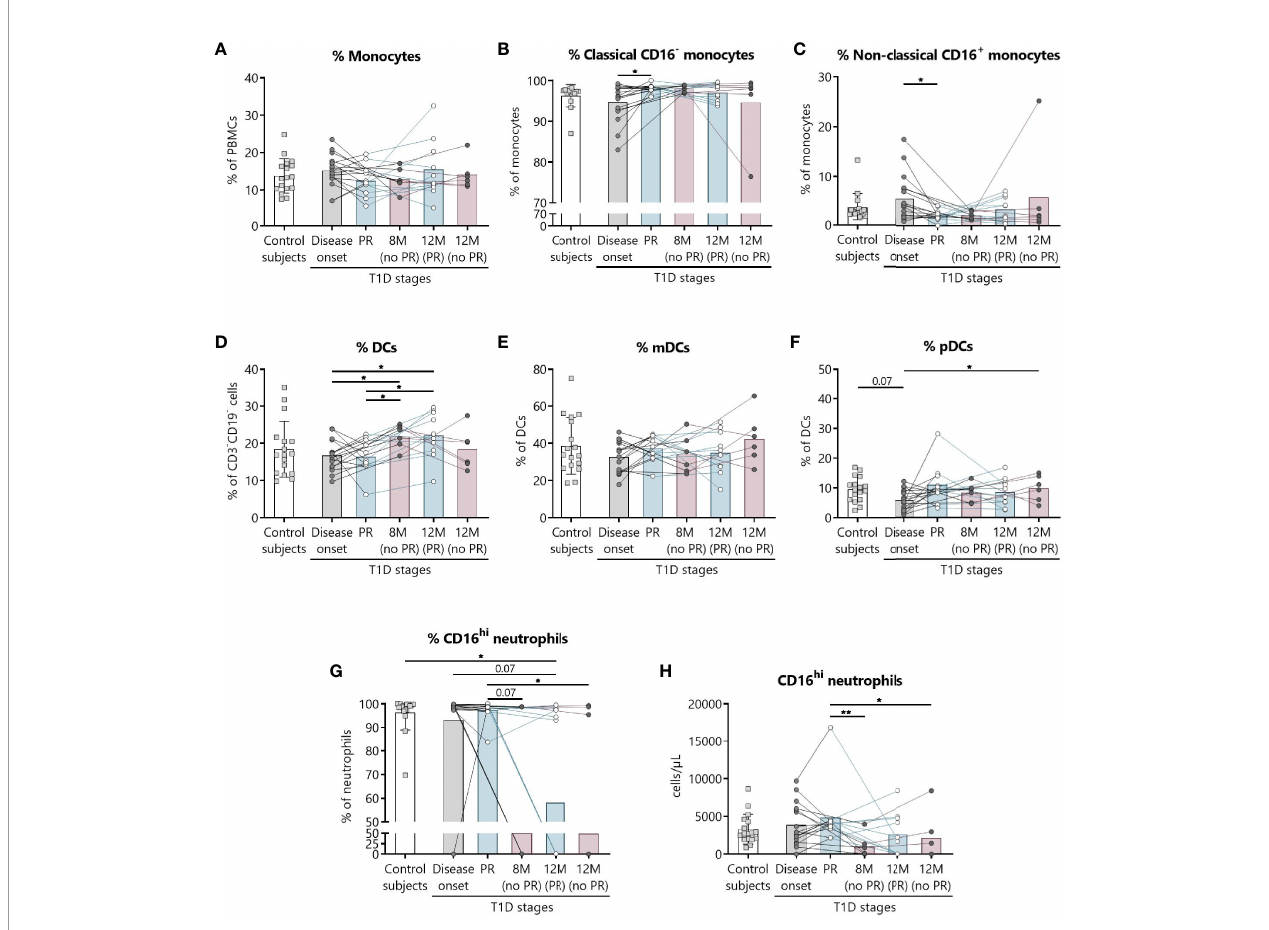
FIGURE 7 | Innate cells are quantitatively altered at the initial stages of T1D. Percentages (%) of (A) monocytes and their subsets (B) classical, and (C) non- classical, of (D) DCs and their subsets (E) mDCs, and (F) pDCs, and (G, H) the percentage (%) and concentration (cells/µl) of CD16 hi neutrophils were determined in peripheral blood of control subjects and patients with T1D at different time-points. Squares represent controls ( n ≥ 16) (white bar), and patients are represented by light gray dots at disease onset ( n = 17) (gray bar), white dots during PR ( n = 11) and for remitter patients at 12 months (12 M PR) ( n = 10) (blue bars), and dark gray dots for non-remitter patients at 8 months (8 M no PR) ( n = 6) and 12 months (12 M no PR) ( n = 6) (pink bars). Bar graphs show mean percentage or absolute count values. Each symbol represents an individual patient. Lines link the same patient throughout the time-points. * P ≤ 0.05, ** P < 0.01 after mixed effects model with Tukey ’ s post-hoc test for longitudinal data, Kruskal – Wallis with Dunn ’ s post-hoc test for comparisons between control subjects and the different T1D time-points, or 2-tailed Mann – Whitney test for comparisons between two unpaired groups of data. P ≤ 0.05 is considered signi fi